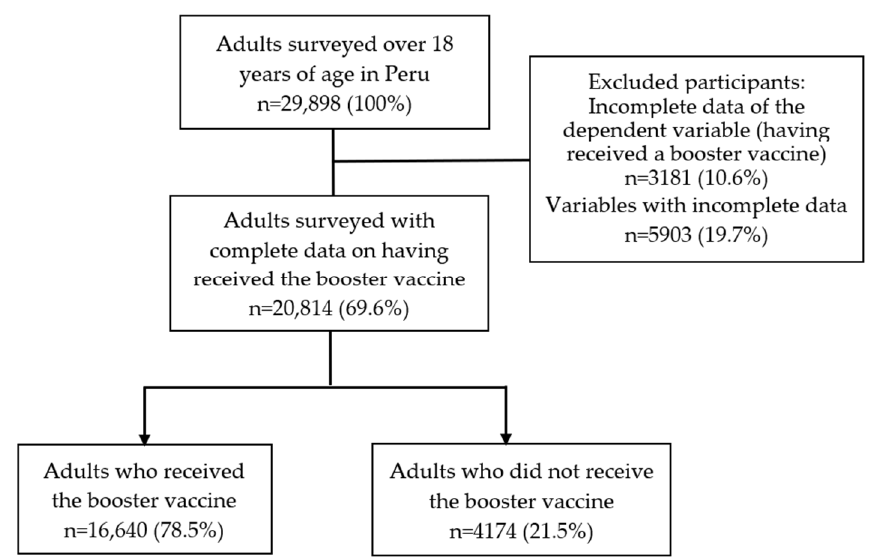
Figure 1. Flowchart of the selection of participants included in the analysis.